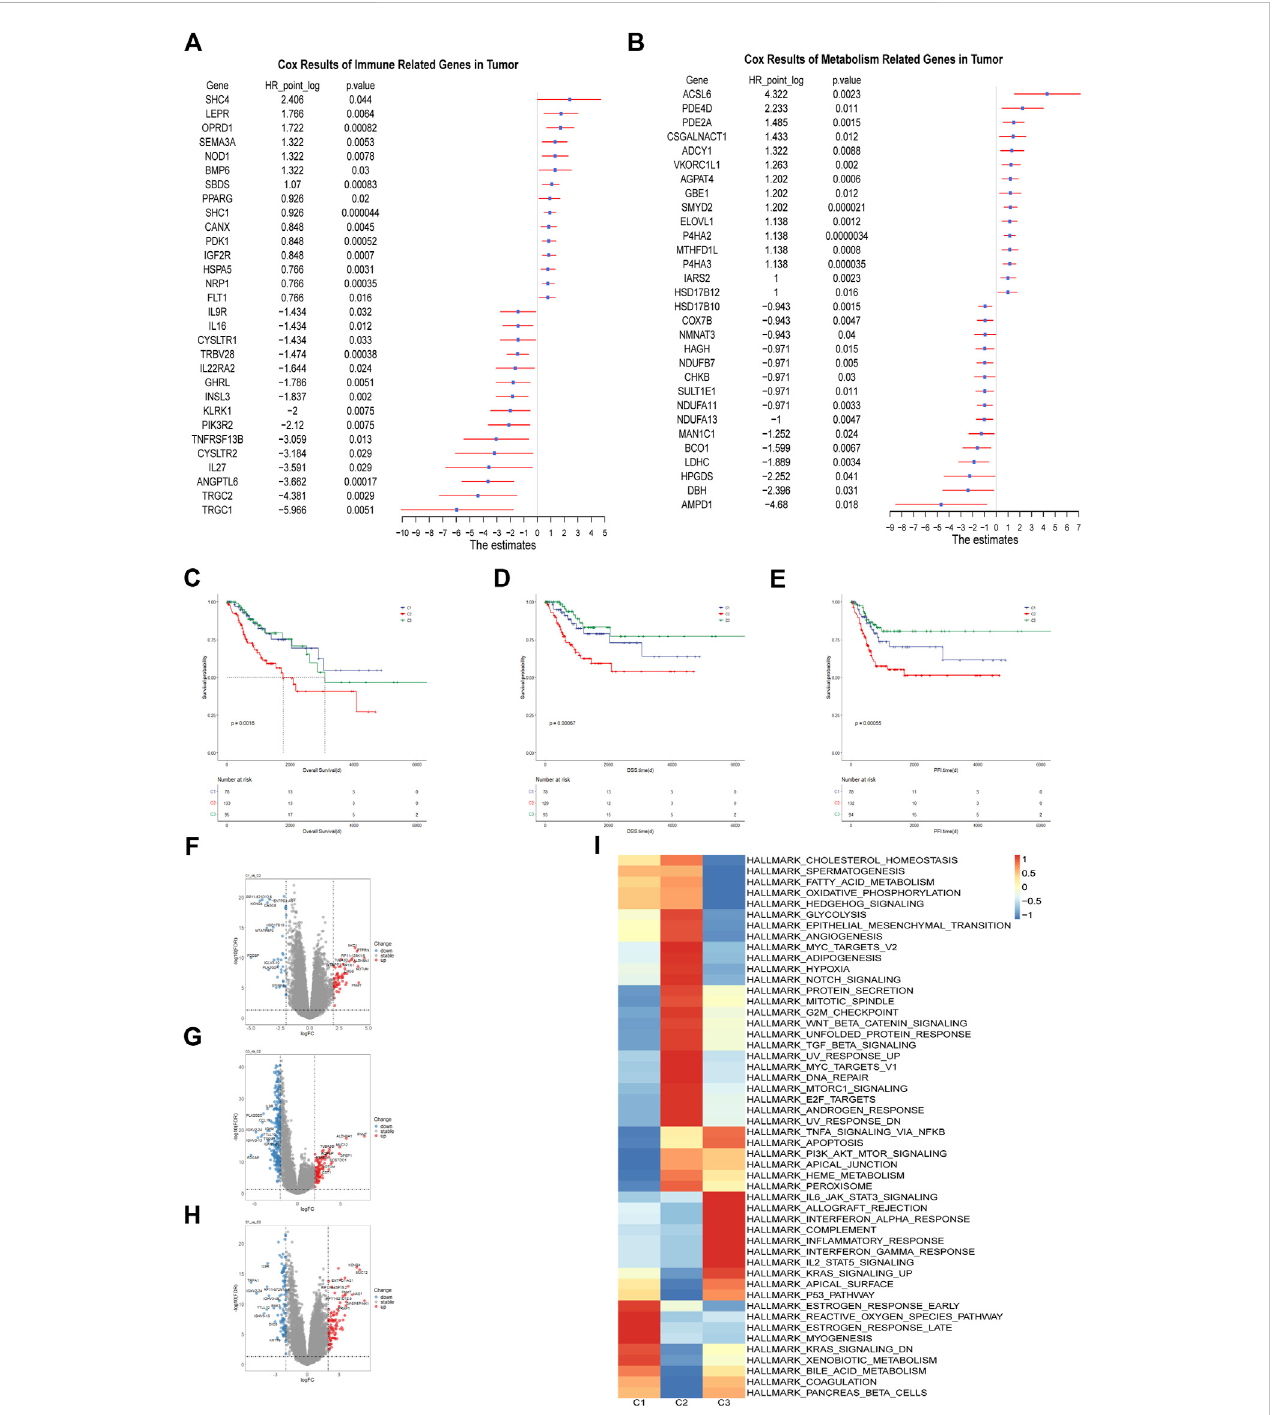
FIGURE 1 Identi fi cation of the Immune-metabolism Subtypes of Cervical Cancer (A) Hazard ratio of top 30 immune related genes that meet the requirements of HR < 0.8 or HR > 1.2 and p < 0.05 associated with overall survival. (B) Hazard ratio of top 30 metabolism related genes that meet the requirements of HR < 0.8orHR > 1.2and p < 0.05associatedwithoverallsurvival. (C – E) Kaplan-Meiercurvesofoverallsurvival,progressionfreeintervalanddiseasespeci fi csurvival amongthesubtypesinTCGAcohort. (F – H) ThevolcanoplotsofdifferentiallyexpressedgenesamongthethreesubtypesinTCGAcohort. (I) Heatmapof differentially enriched hallmark pathways from GSEA database among three subtypes in TCGA